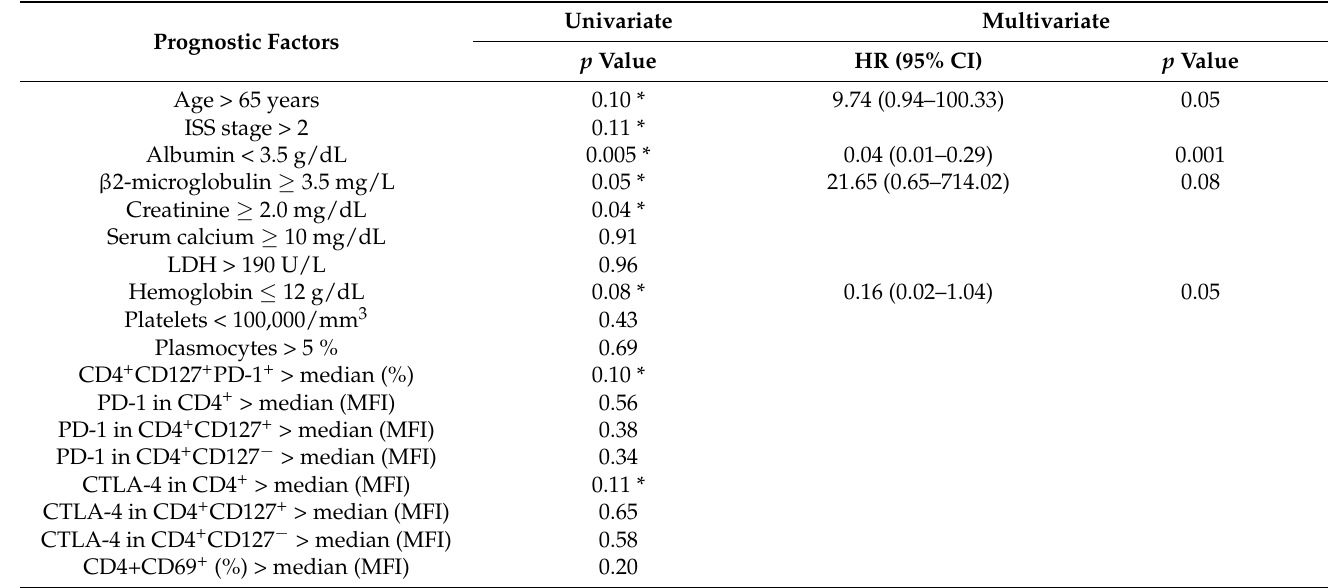
Table 5. Univariate and multivariate Cox regression